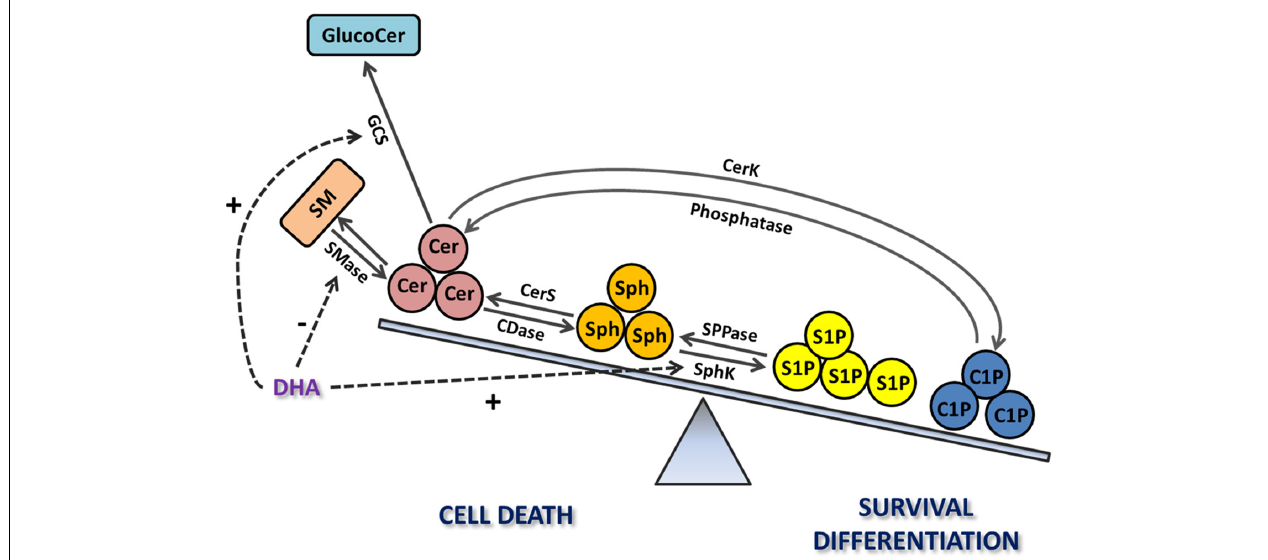
FIGURE 4 | The relevance of the sphingolipid rheostat in retina photoreceptors. Increases in Cer levels through the activation of its de novo synthesis or the SMase pathway trigger photoreceptor death; this death is also induced after Cer hydrolysis to increase Sph levels, mediated by ceramidase (CDase). In turn, S1P and C1P promote photoreceptor survival and differentiation. Docosahexaenoic acid (DHA) promotes survival by regulating the sphingolipid rheostat, inhibiting SMase or stimulating the synthesis of glucosylceramide (GlucoCer) to decrease Cer levels or enhancing the synthesis of S1P. Exogenous addition of C1P also promotes photoreceptor survival and